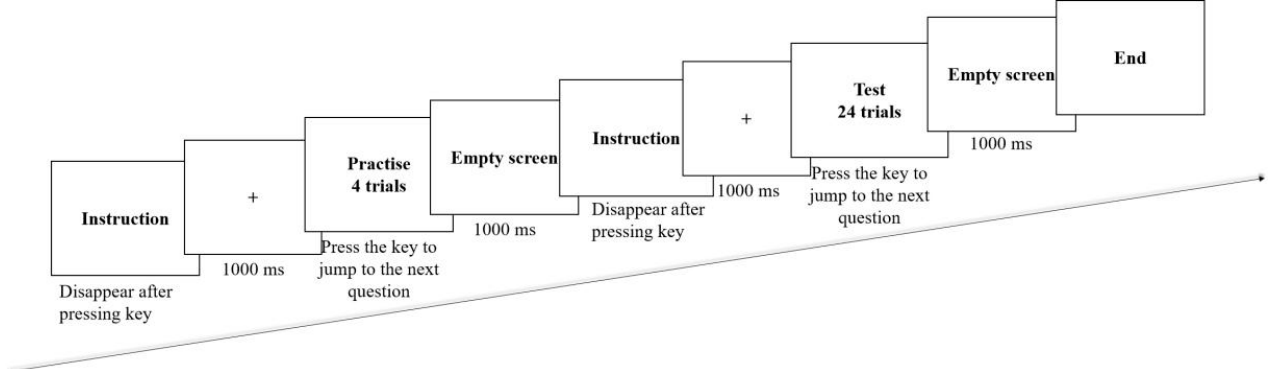
Figure 3. The stimulus presentation designed in the